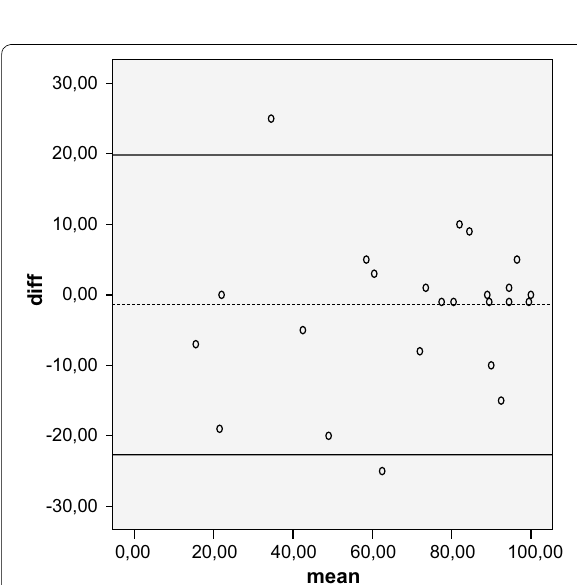
Fig. 5 Bland–Altman plot showing test–retest results for 33 patients completing the Italian version of the Oxford index. The dashed line shows the mean difference; solid lines show the 95 % confidence